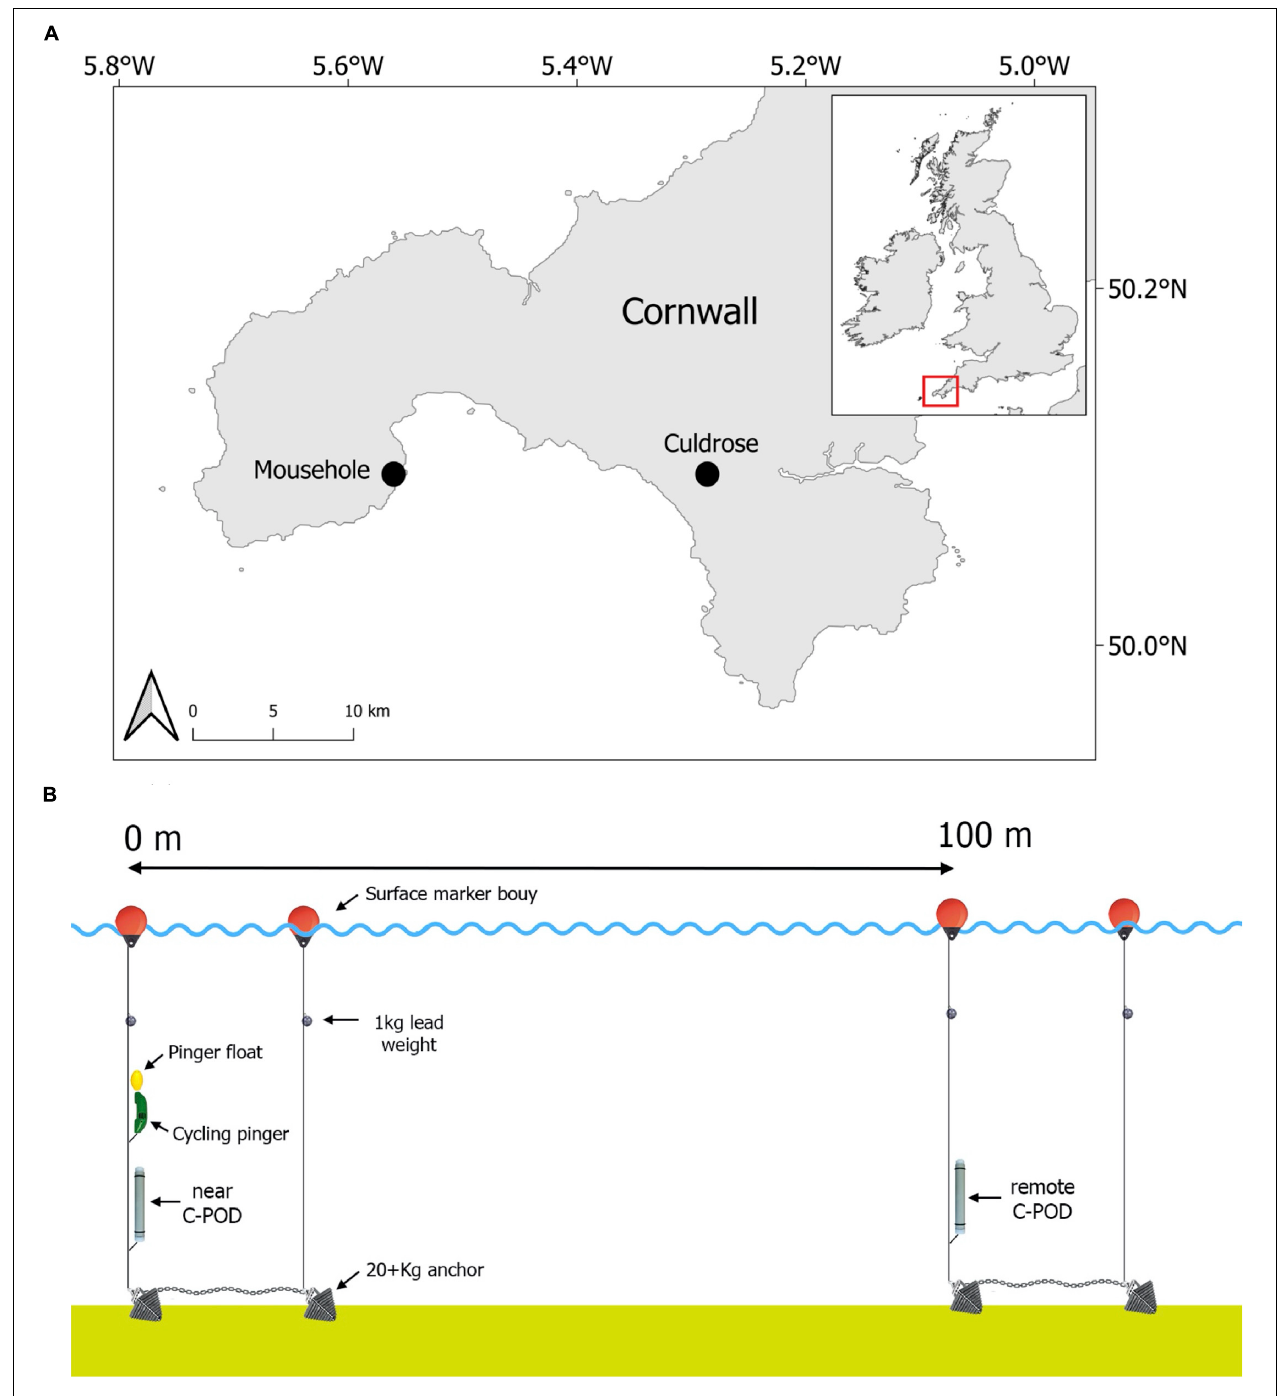
FIGURE 1 | Study location (A) and study design (B) . C-POD: passive acoustic logger.